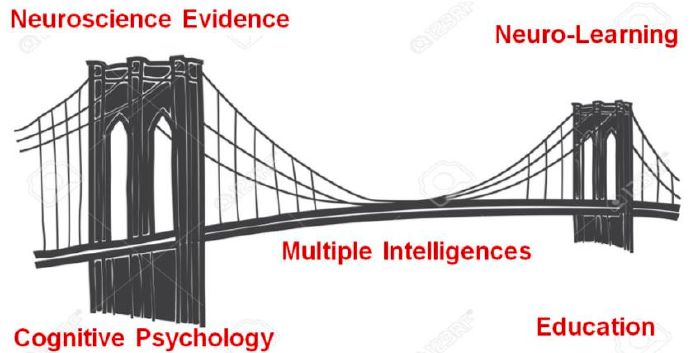
Figure 1. Personalized educational cognitive neuroscience: a framework. Note : The bridge between existing psychological models of cognition/behavior and education is spanned by multiple intelligences theory supported by neuroscience validity and efficacy evidence.